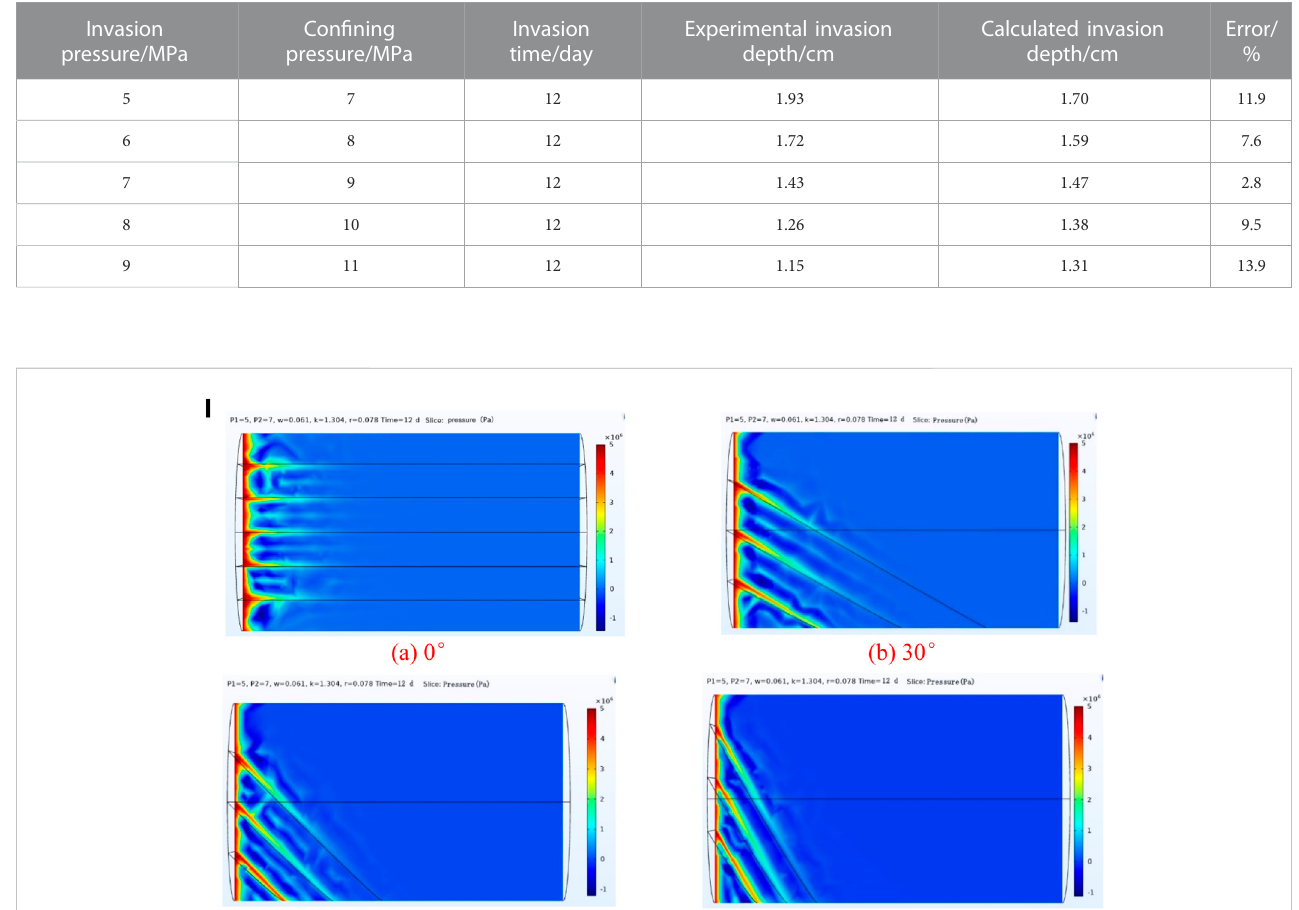
Frontiers in Earth